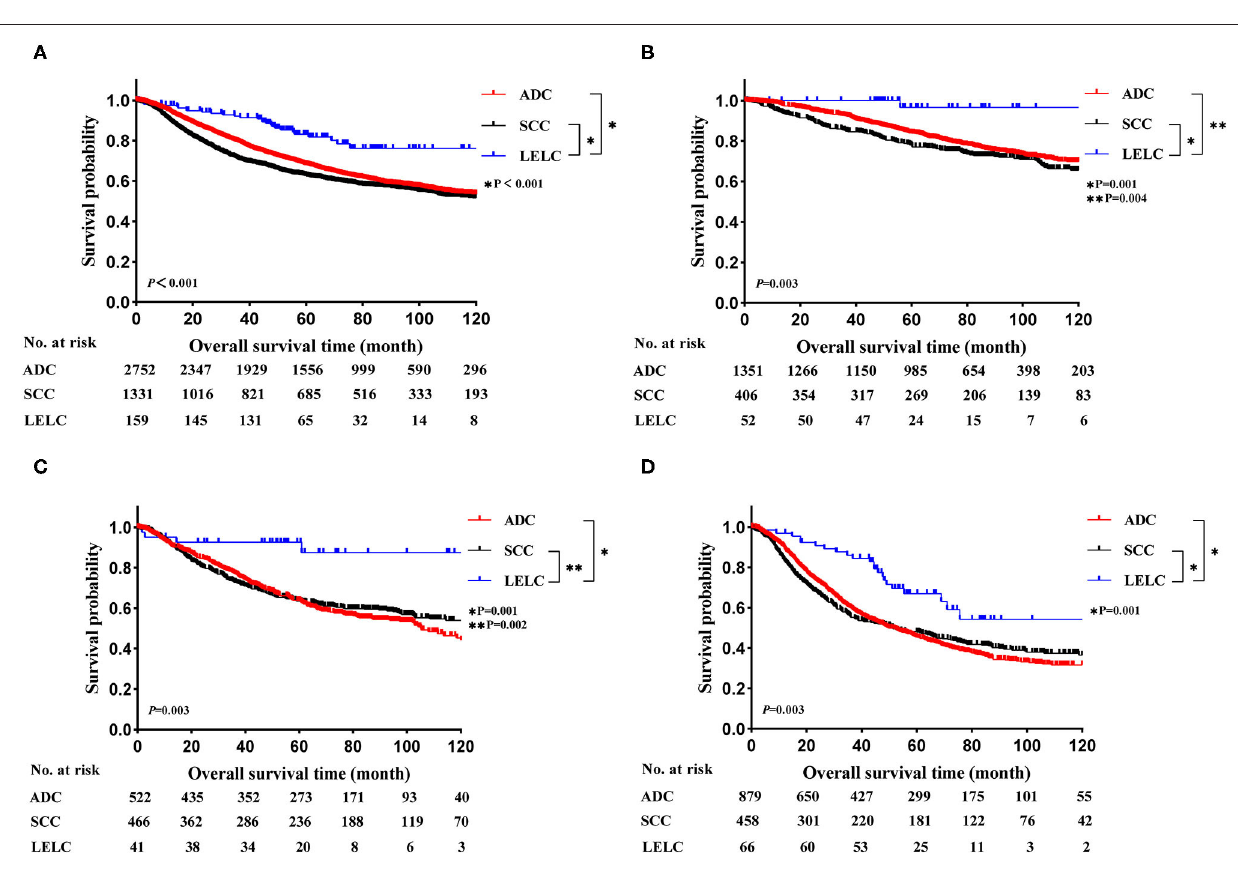
FIGURE 2 | Kaplan-Meier estimates of OS in LELC vs. other NSCLCs across different TNM stages. (A) The entire cohort; (B) stage I cohort; (C) stage II cohort; (D) stage III cohort. LELC, lymphoepithelioma-like carcinoma; ADC, adenocarcinoma; SCC, squamous cell carcinoma; NSCLC, non-small cell lung cancer; OS, overall